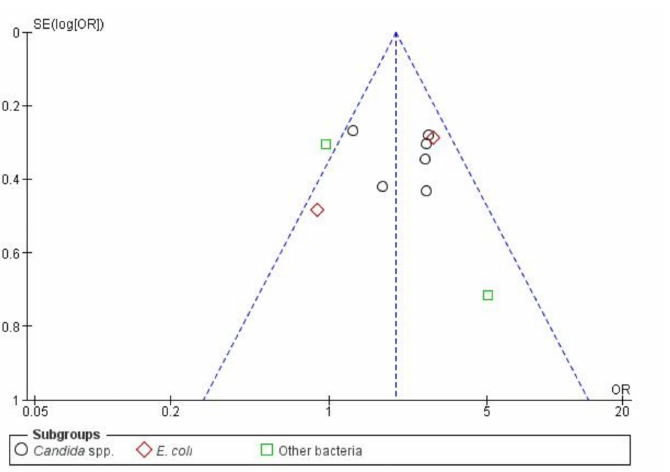
Figure 6. Funnel plot of standard error by OR (Odds Ratio)—BSIs (Bloodstream infections) resistance.